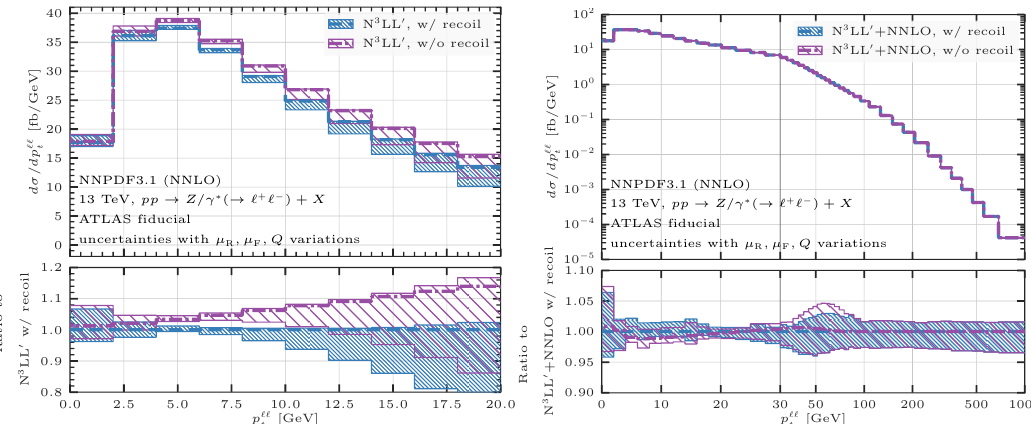
spectra in the fiducial ATLAS setup with t